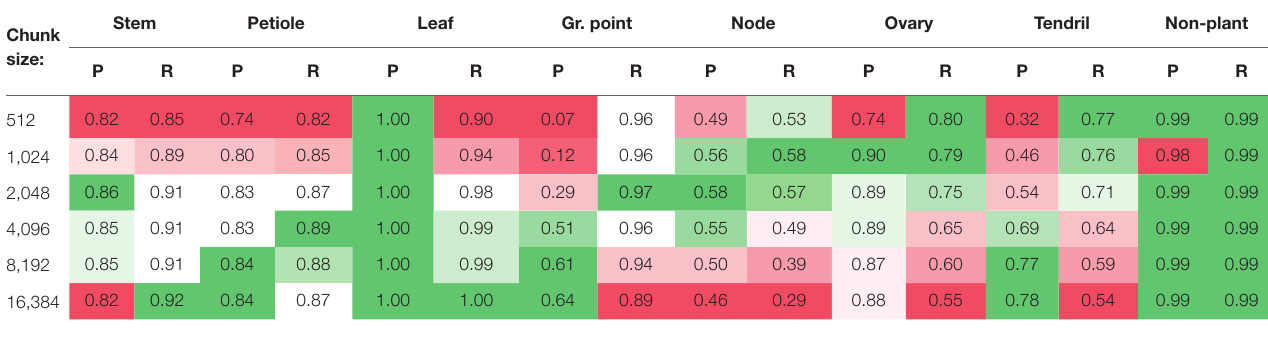
TABLE 3 | Precision (P) and Recall (R) per class, for the six different chunk sizes. Stem Petiole Leaf Gr. point Node Ovary Tendril Chunk size: